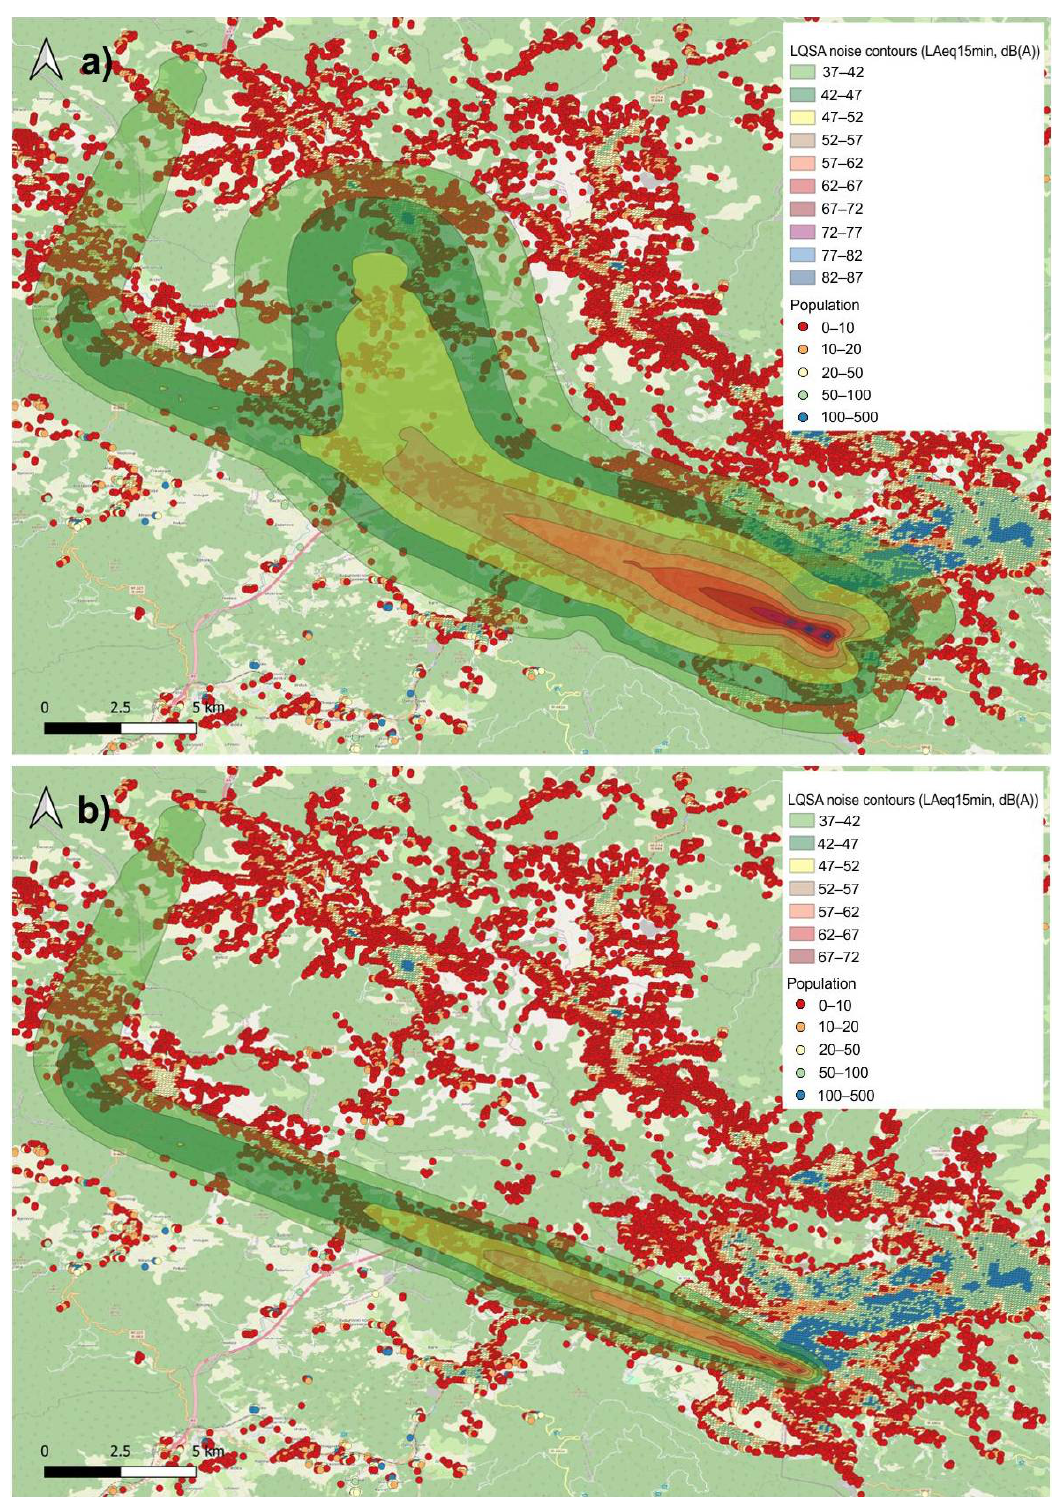
Figure 4. L Aeq ,15min noise contours for Sarajevo Airport, ( a ) with TAM-related delays and ( b ) without TAM-related delays.